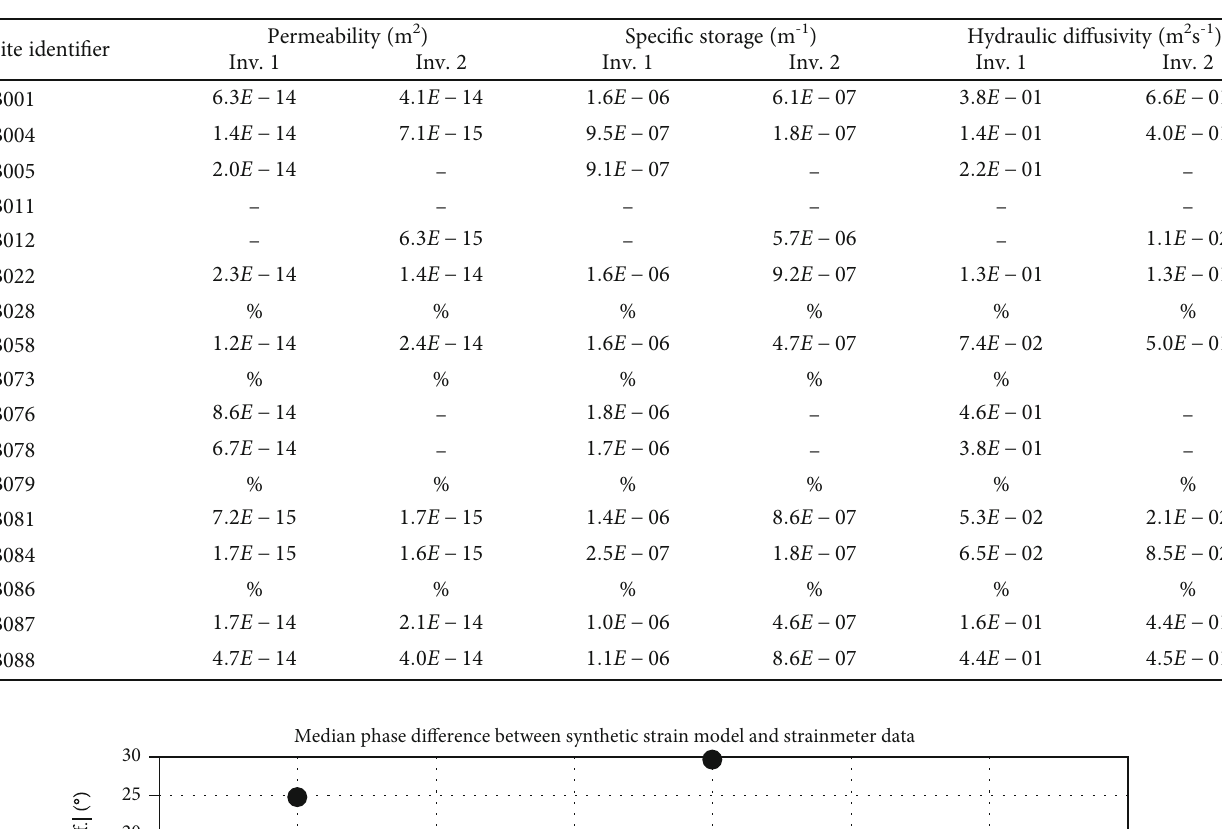
Table 4: Median values of hydrologic properties. Inversion 1 uses fi ltered borehole pore pressure and fi ltered modeled strain for analysis. Inversion 2 uses fi ltered borehole pore pressure and fi ltered strainmeter data for analysis.. – indicates phase lag outside of two fl ow models. % indicates no M component in pore pressure. 2